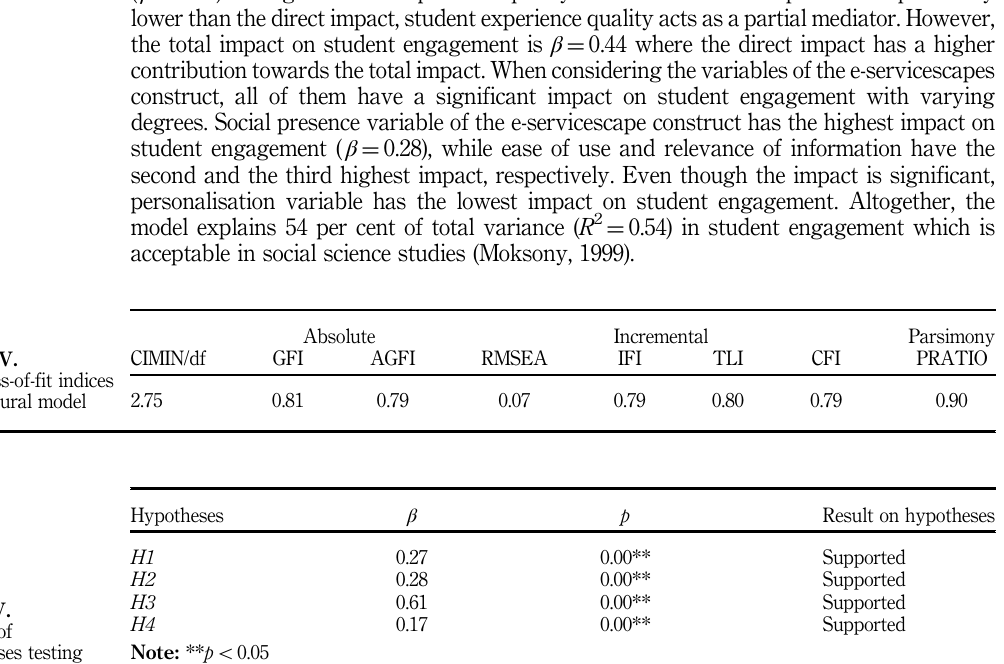
Table V. Results of hypotheses